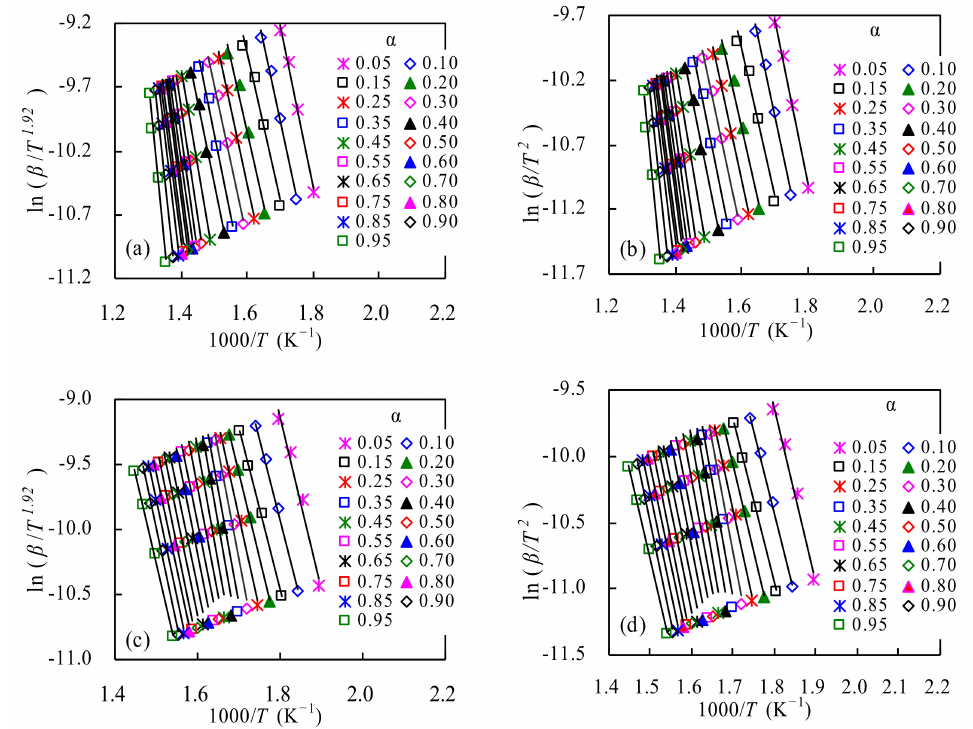
Figure 4. Linear Arrhenius plots for TSPU ( a , b ) and WPU ( c , d ): ( a , c ) SK method ln( β / T 1.92 ) vs. 1000/ T , and ( b , d ) CR method ln( β / T 2 ) vs. 1000/ T